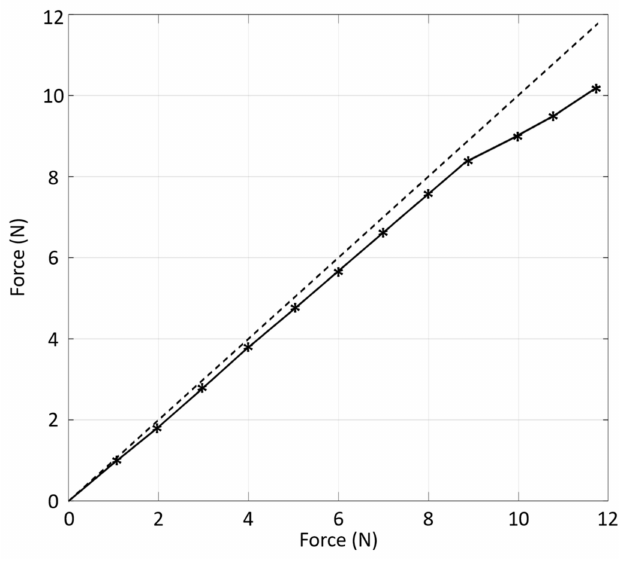
Figure 7. Load variation estimation test. Dashed line: real applied force. Solid line: estimated